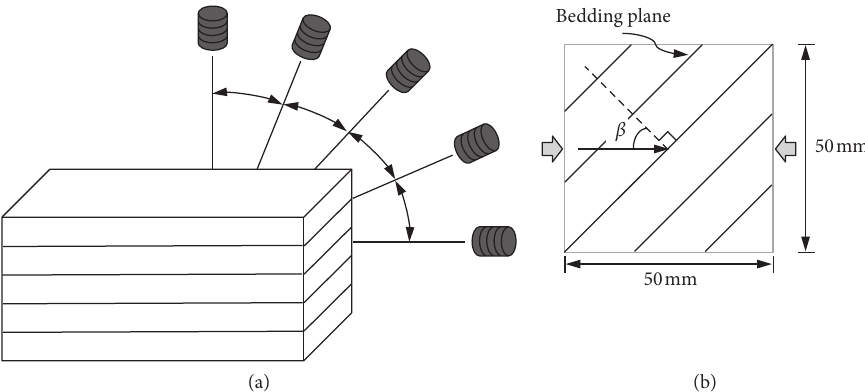
Figure 2: Preparation of layered phyllite specimens with different bedding angles. (a) Schematic diagram of sample acquisition. (b) Definition of bedding angle and specimen size.